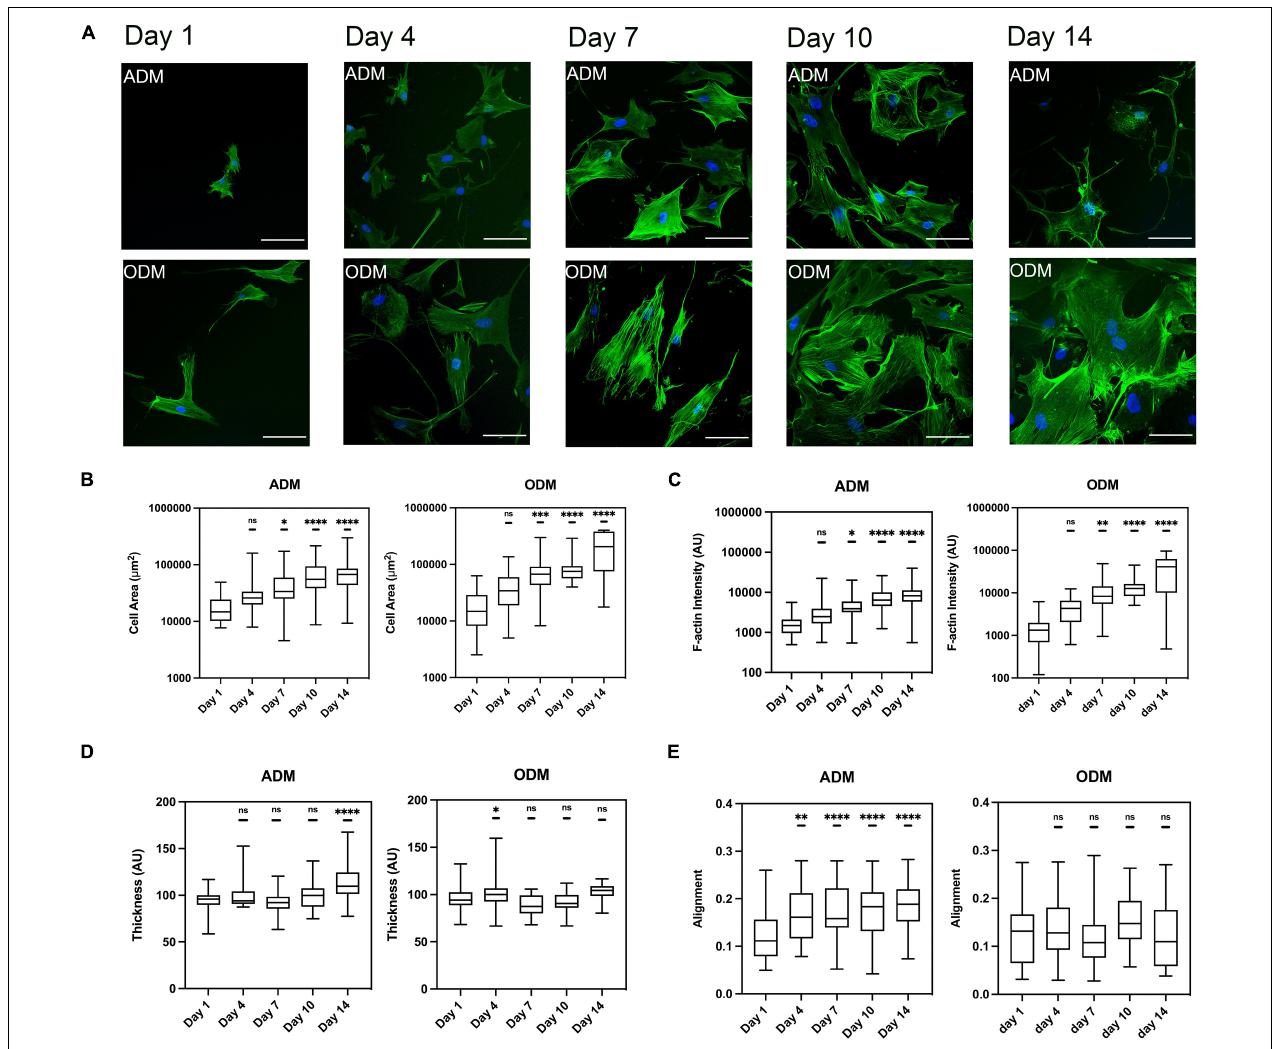
FIGURE 3 | The F-actin cytoskeleton change of hMSCs during differentiation. (A) Cytoskeleton of hMSCs in ADM (1st row) and ODM (2nd row) at different time points, blue for DAPI and green for phalloidin, scale bar 100 um. Box plots show the results of the (B) cell area, (C) F-actin fiber intensity, (D) thickness, and (E) alignment of hMSCs during adipogenic/osteogenic differentiation at different time points. Box plots extend from the 10th to the 90th percentile, whiskers from min to max. A total of n = 45 (day 1, ADM), n = 25 (day 4, ADM), n = 40 (day 7, ADM), n = 52 (day 10, ADM), n = 39 (day 14, ADM), n = 44 (day 1, ODM), n = 66 (day 4, ODM), n = 26 (day 7, ODM), n = 19 (day 10, ODM), n = 13 (day 14, ODM), and cells were analyzed from n = 3 repeats. Asterisks indicate a statistical difference ( ∗ P < 0.05, ∗∗ P < 0.01, ∗∗∗ P < 0.001, ∗∗∗∗ P < 0.0001, and obtained using a nested 1-way ANOVA design followed by a multiple comparisons Dunnett’s test against day 1). ns indicates not significant